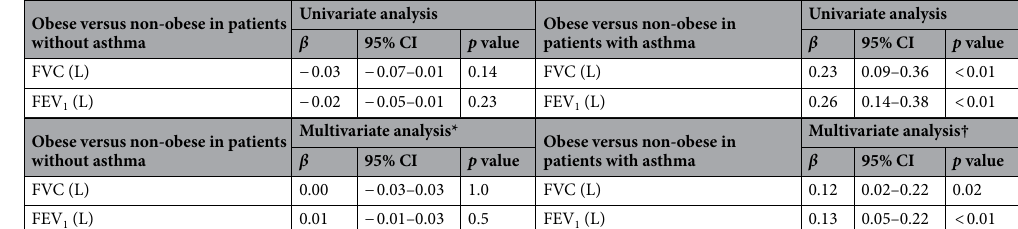
Obese versus non-obese in patients without